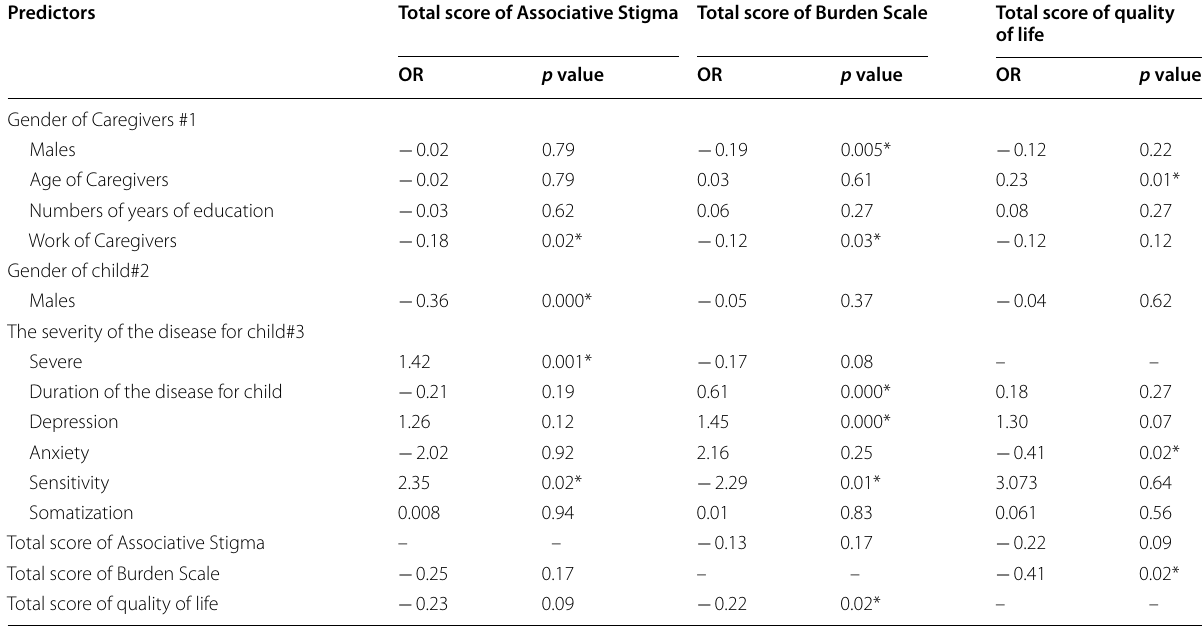
Table 3 Multivariate generalised regression model of Total score of Associative Stigma, Total score of Burden Scale, and Total score of quality of life among studied